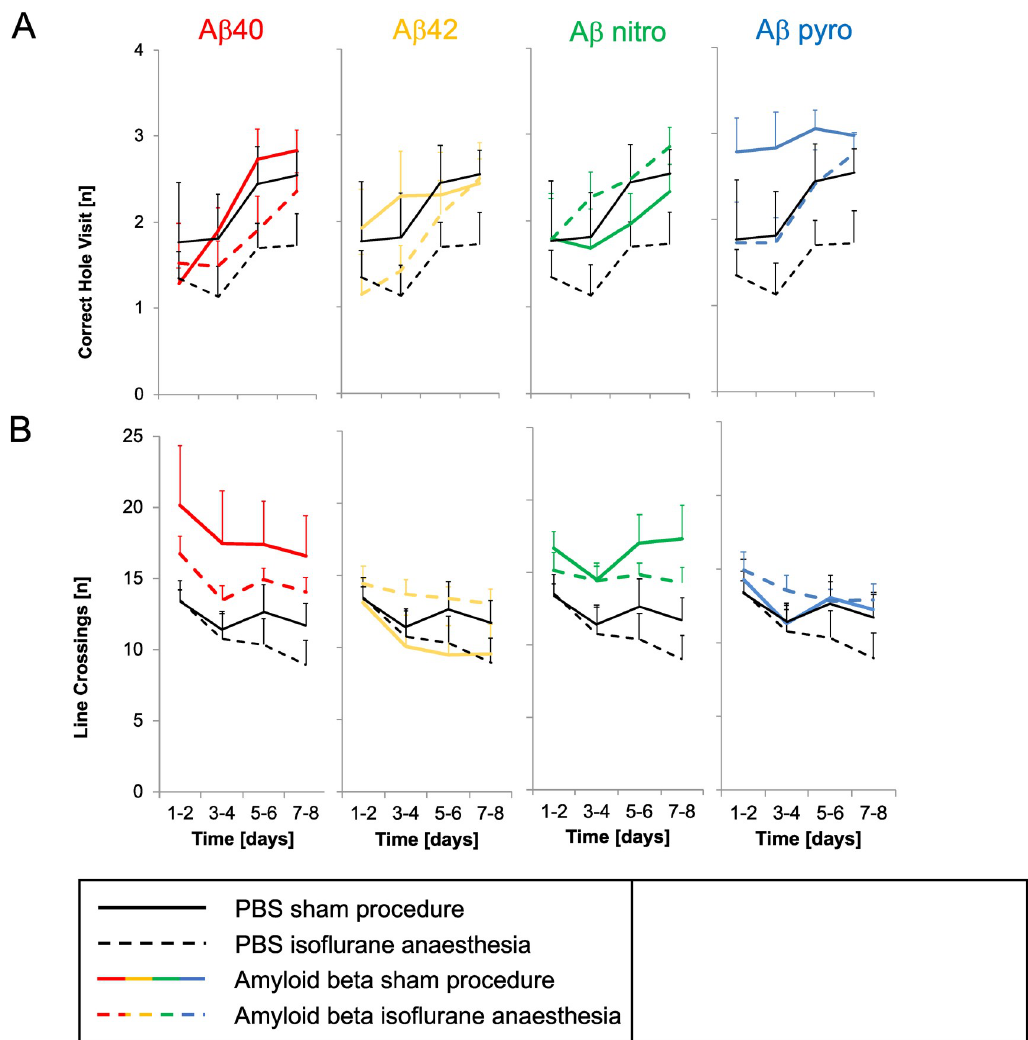
Fig 3. Behavioural parameters of mice injected with different A β subspecies after anaesthesia compared to control. A: Correct Hole Visits (exploratory motivation), B: Line Crossings (locomotor activity); mean of all tests on two days and standard error